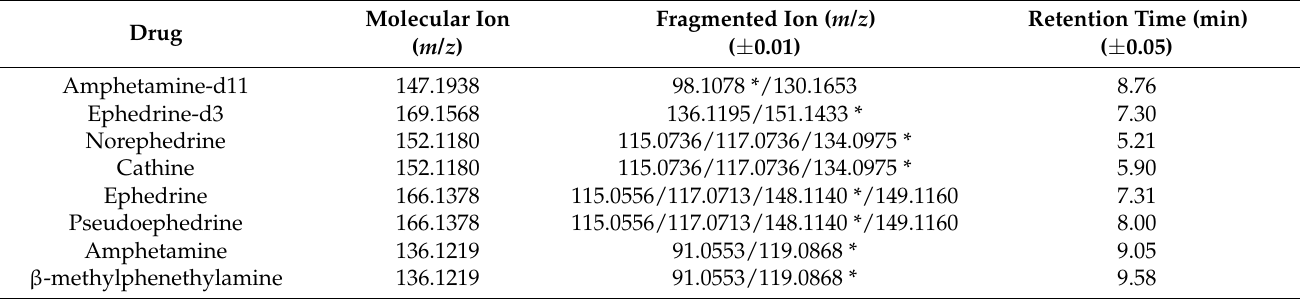
Table 1. Analytical parameters of the analytes (positive ionization